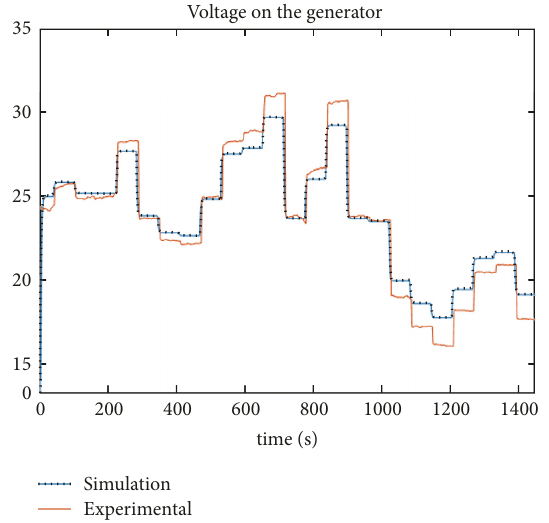
Figure 14: Voltage output for a varying wind speed input with control disabled.